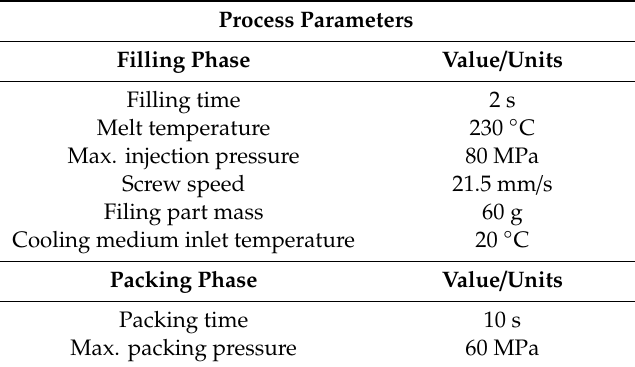
Table 1. Process parameters, boundaries and material properties for the transient thermo-mechanical finite element analysis (FEA) of the injection moulding process with an overall cycle time of 33